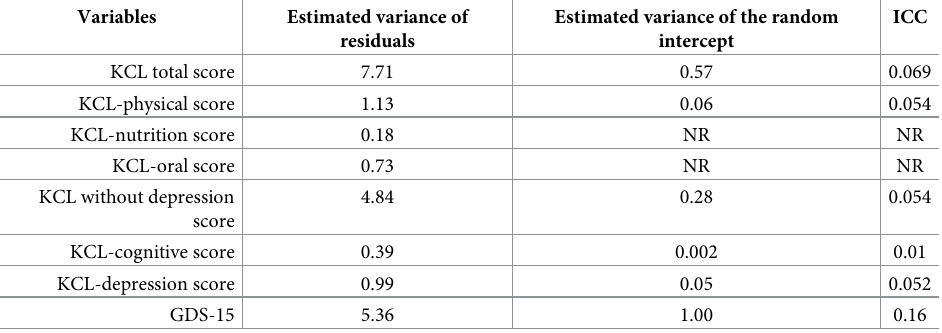
Table 3. The result of intra-class correlation coefficient (the null model’s estimation) among